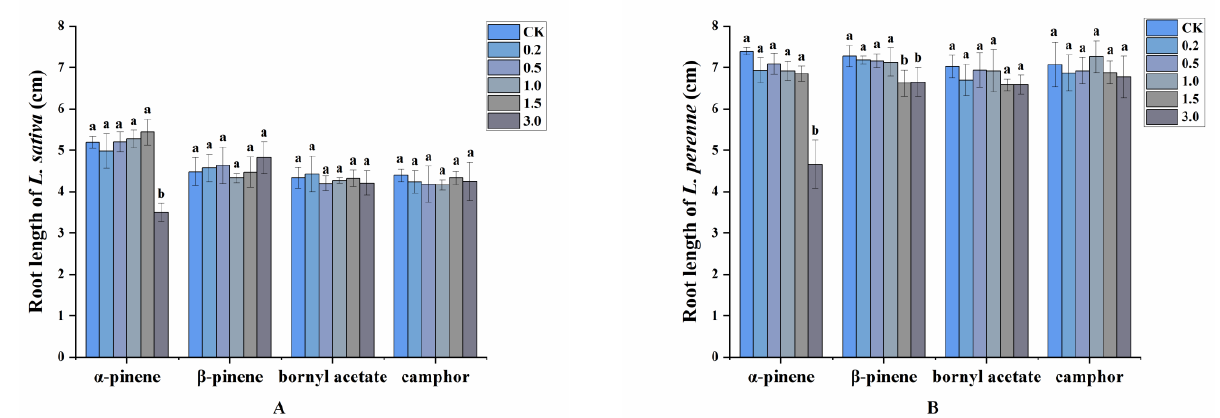
Figure 4. Allelopathic effects of four main volatile compounds on the root length of ( A ): L. sativa and ( B ): L. perenne . Each value is the mean of five replicates ± SD ( n = 30). Means with different lowercase letters indicate significant differences at p < 0.05 level according to ANOVA and Fisher’s LSD test.